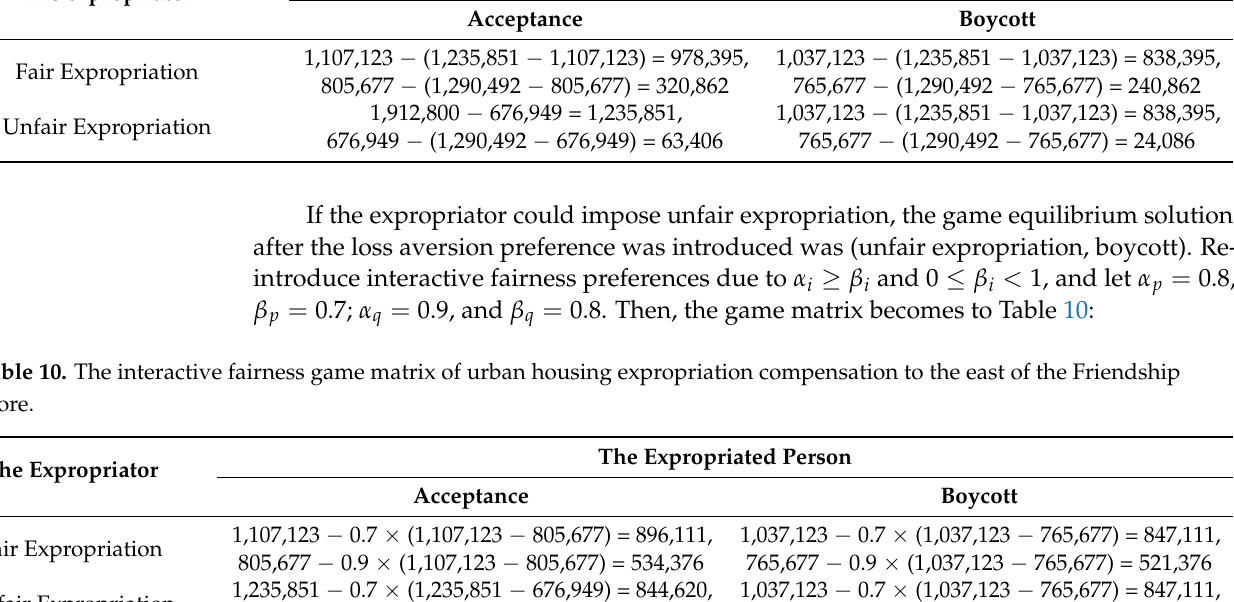
Table 9. The loss aversion game matrix of urban housing expropriation compensation to the east of the Friendship Store. The expropriator